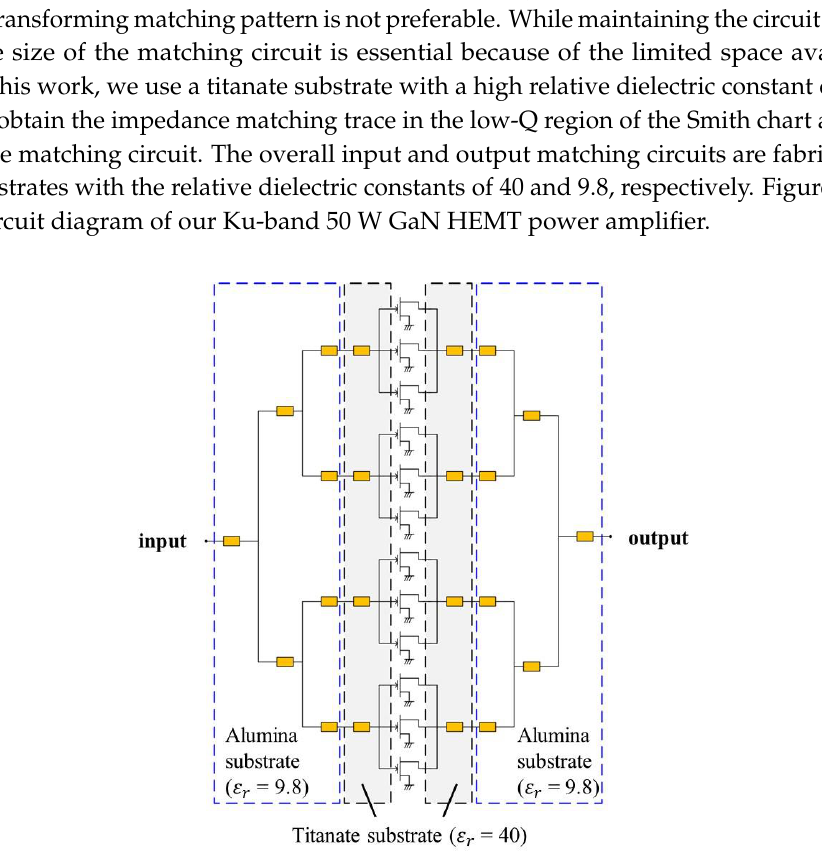
Figure 2. Comparison of S-parameter and load-pull simulation results of the conventional large-signal CGHV1J070D model and our modified r7 model: ( a ) S-parameter simulation; ( b ) load-pull simulation ( left : modified r7 model, right : conventional CGHV1J070D model).